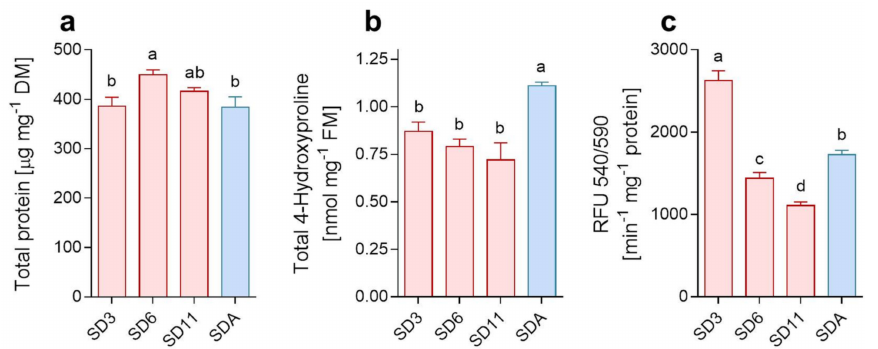
Figure 2. Total protein, collagens and MMPs. Changes in ( a ) total protein content, ( b ) total content of collagens estimated based on 4-hydroxyproline released upon acidic hydrolysis of larval total proteins, and ( c ) activity of general metalloproteinases (MMPs, collagenases). All analyses were performed on extracts of whole body larvae of different variants (diapause maintenance: SD3, SD6, SD1 (red columns); cold acclimation: SDA (blue column); see Table 1)) and each column is a mean of 3 biological replicates. Means were compared using one-way ANOVAs followed by Bonnferoni’s multiple comparison tests (different letters indicate significantly different means). Note that nanomolar amounts of hydroxyproline were released from collagens upon acidic hydrolysis ( c ), while the total pool of free hydroxyproline in larval tissues is three orders lower—approximately 4–8 femtomoles